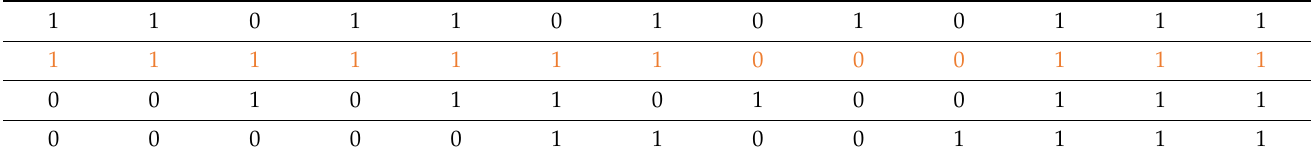
Table 11. New chromosome derived from the horizontal mutation operator.